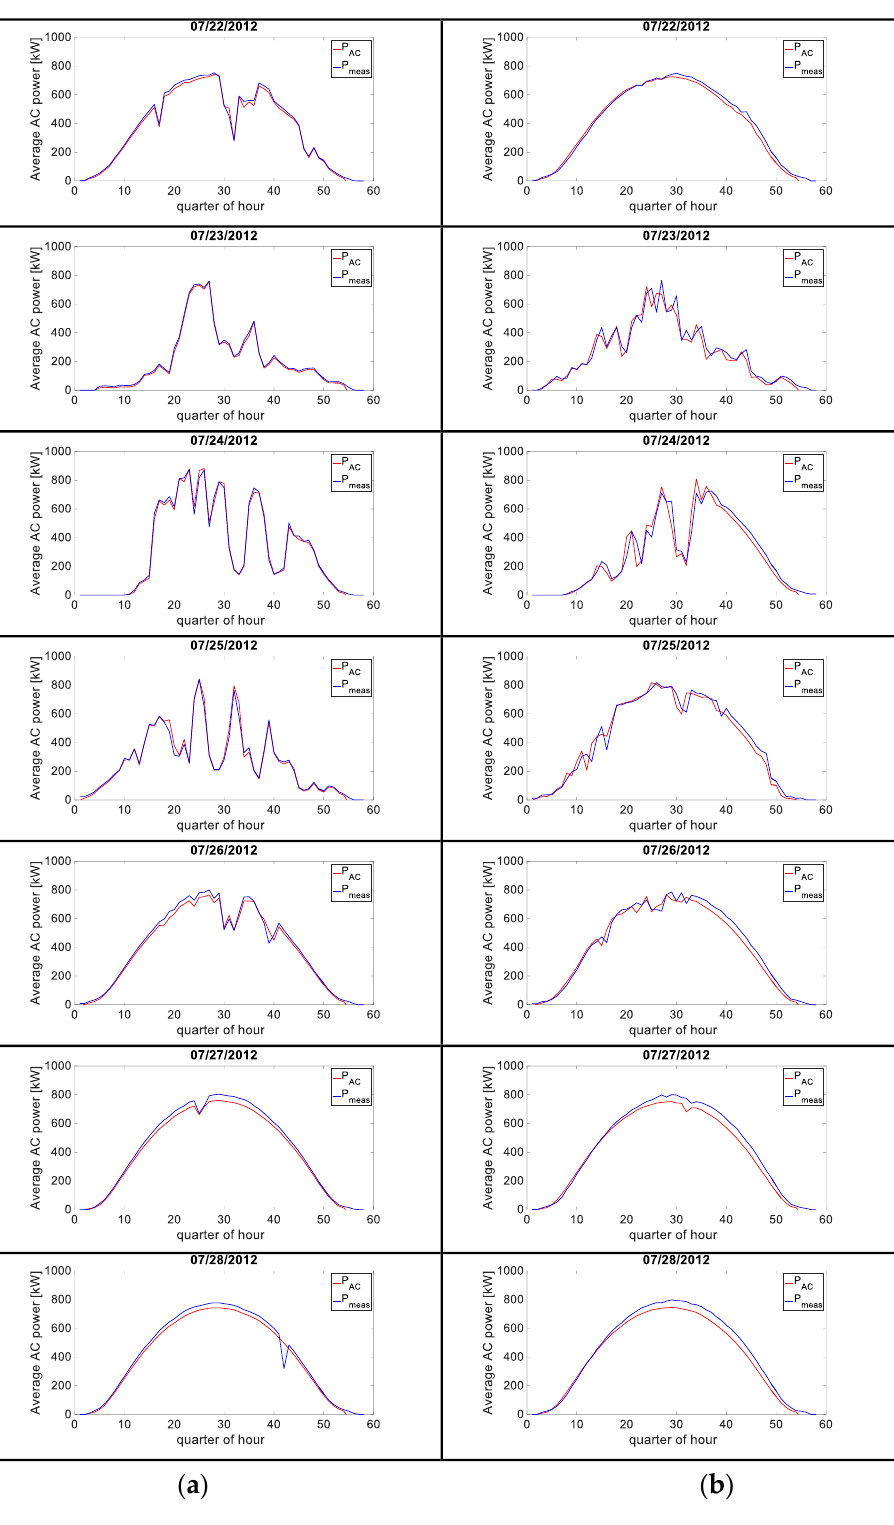
Figure 12. Comparison between PV power measurements and simulations for seven consecutive days of July 2012. ( a ) Site “Gi”; ( b ) Site “Ma”.